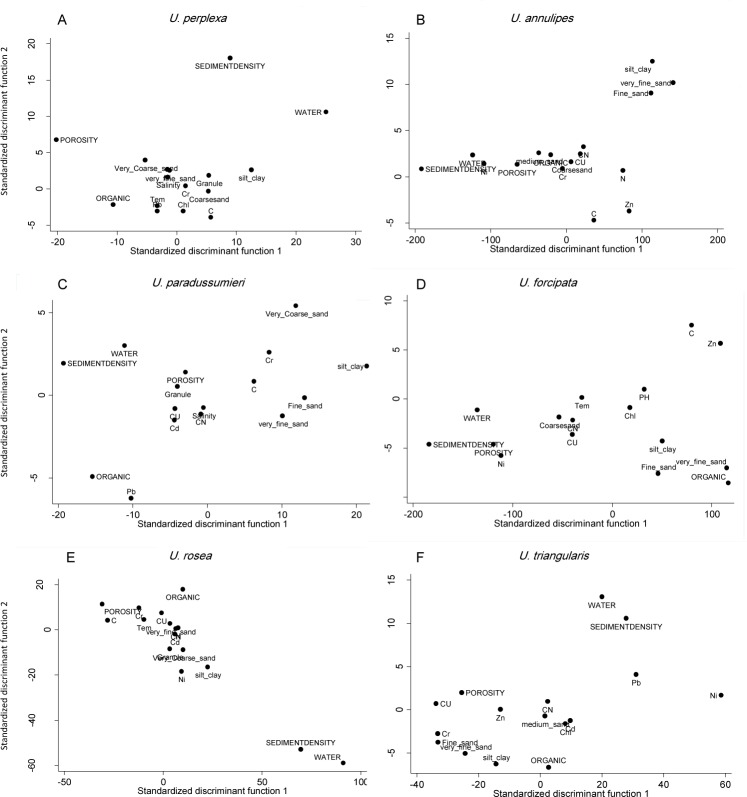
Standardized discriminant function plot for different species of fiddler crabs.Environmental variable located on the edge of plot are significantly different between abundant, rare and absence sites and therefore plays important role in determination of crab habitat.